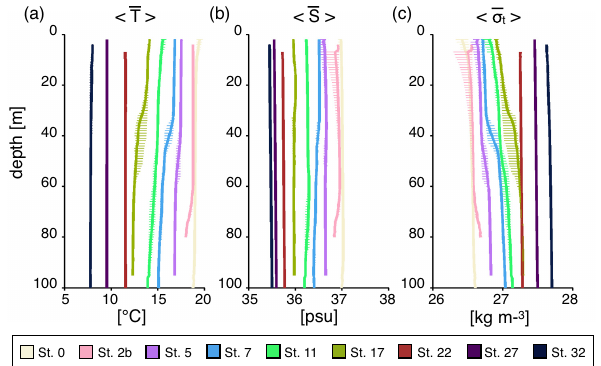
Fig. 3. Depth-binned and station-averaged profiles of (a) temper- ature T , (b) salinity S , and (c) sigma-t σ t (density ρ − 1000) at 9 selected stations. The ranges of minimum and maximum val- ues around the station-average are also shown as horizontal bars. The overbar indicates a trimmed–smoothed–sharpened–filtered and binned quantity, and the angle brackets indicate a